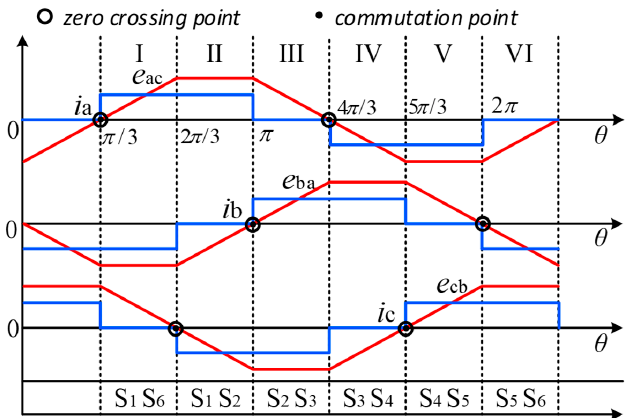
Figure 2. Line back electro-motive force (BEMF) and stator current of each phase.